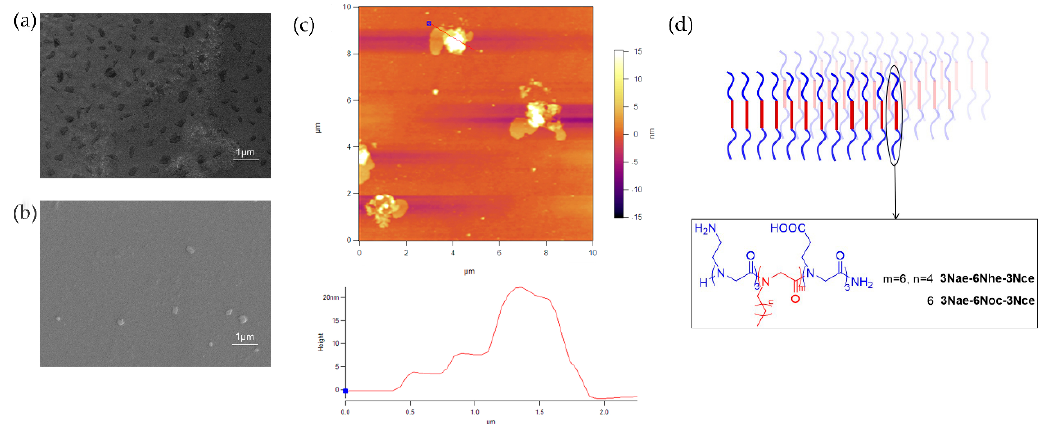
Figure 4. SEM images of self-assembled membrane-like nanomaterials from ( a ) 3Nae-6Noc-3Nce and ( b ) 3Nae-6Nhe-3Nce; ( c ) AFM image of self-assembled membrane-like nanomaterials from 3Nae-6Noc-3Nce and the cursor profile for the line in the image; ( d ) illustration of monolayer formed from peptoid triblock copolymers.